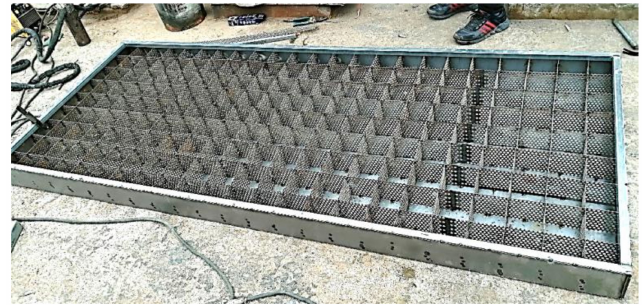
Figure 4. Entity image of multi-cavity steel